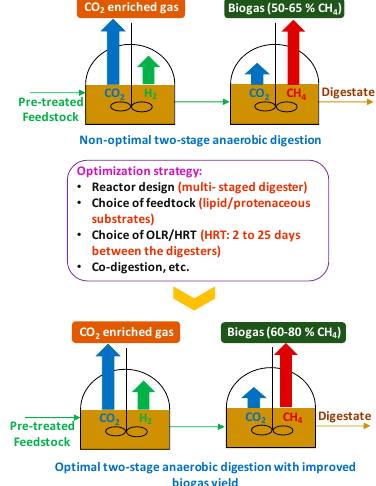
Figure 1. Methane content in biogas between conventional and optimum anaerobic digestion (AD).